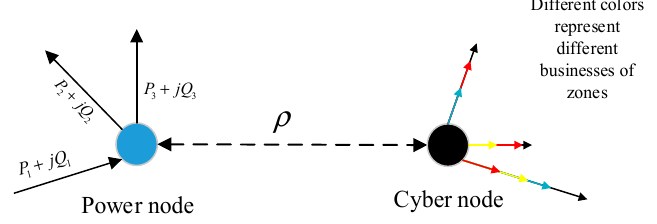
Figure 2. Utilization model for coupled node pairs.